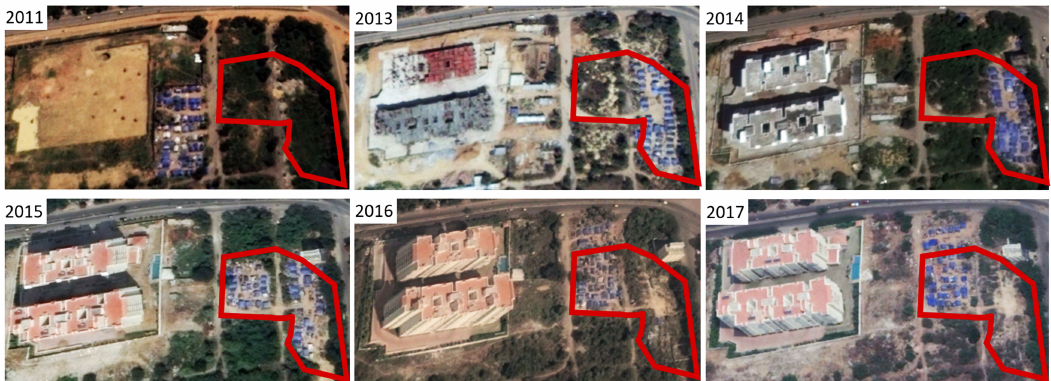
Figure 8. Spatiotemporal dynamics of a deprived area in Bangalore (Image source: Google Earth)—the red boundaries represent the slum boundaries delineated in a city-wide mapping campaign by a local team in 2017 for the Dynaslum project.